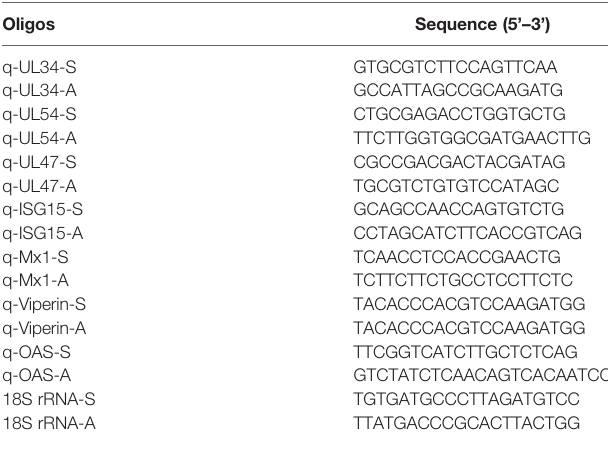
TABLE 3 | Primers used in qPCR